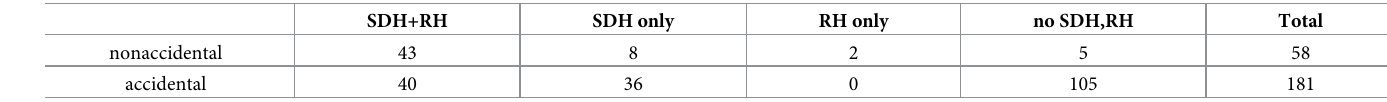
Table 6. The relationship between subdural hematoma, retinal hemorrhage and